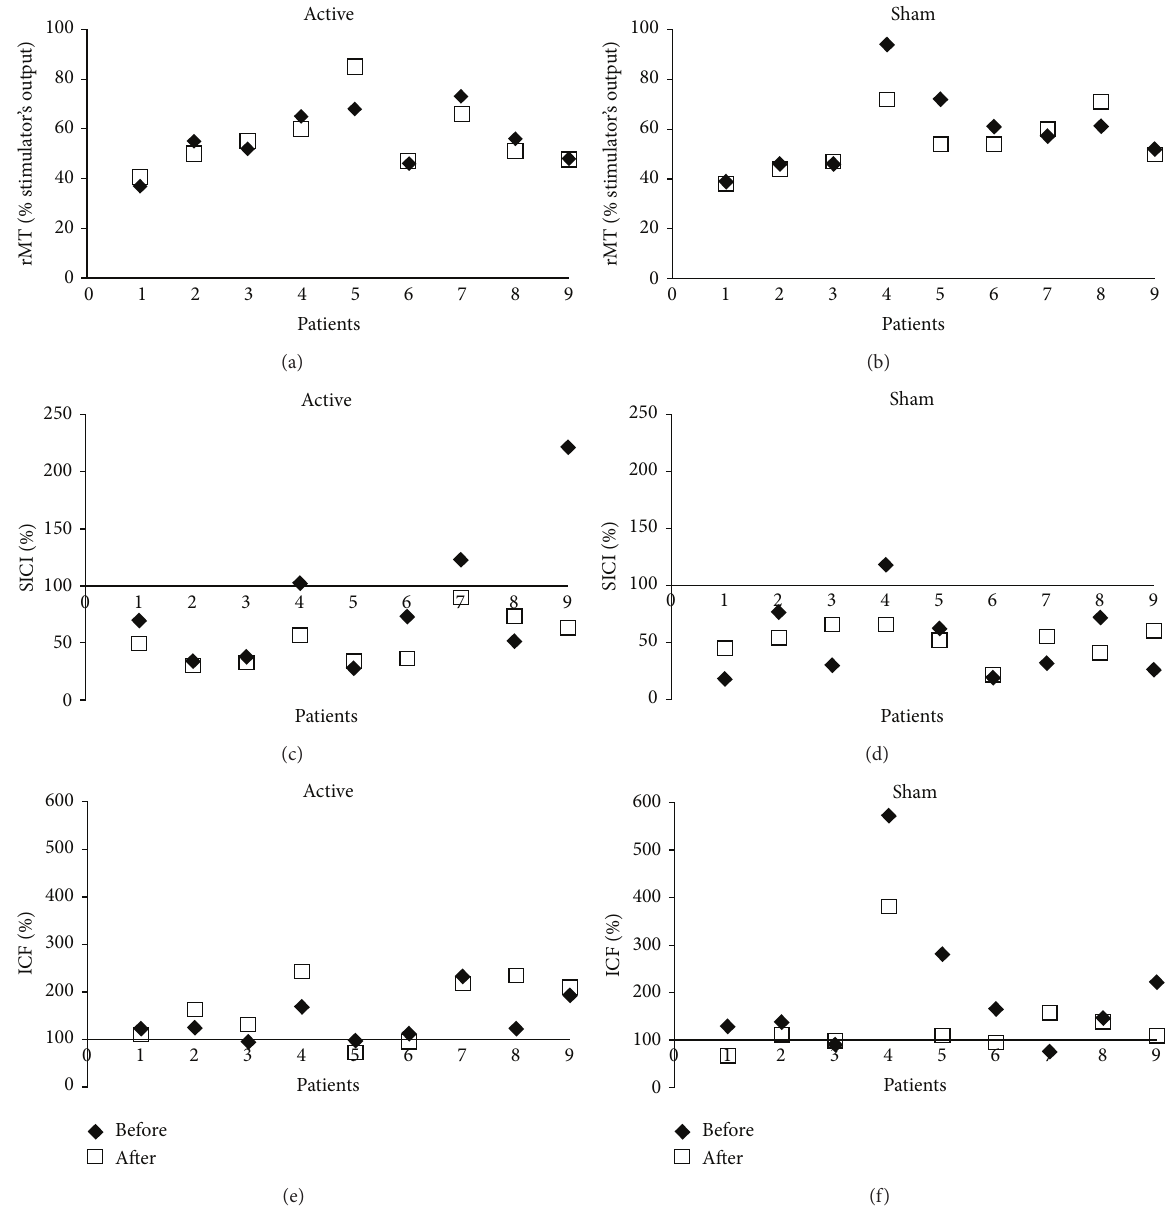
Figure 2: Differences in changes in rMT, SICI, and ICF between the sham and active groups. rMT = resting motor threshold; SICI = short- interval intracortical inhibition; ICF = short-interval intracortical